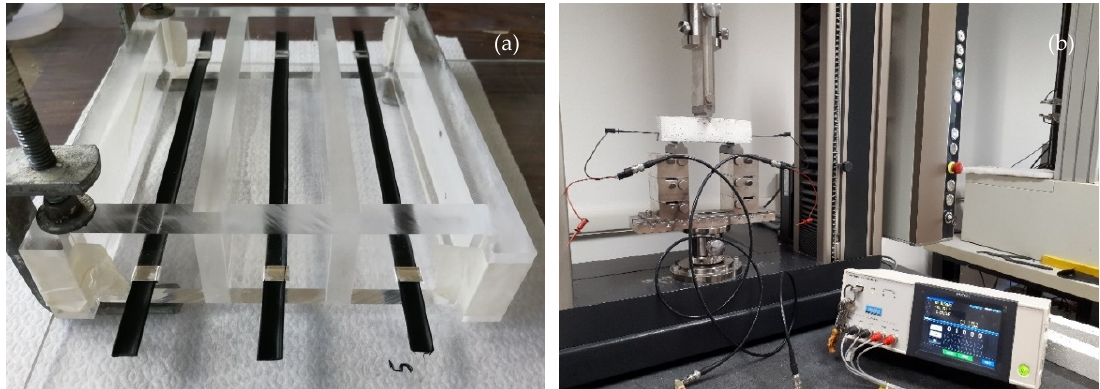
Figure 1. ( a ) Polypropylene / carbon nanotubes (PP / CNT) strips in the PMMA mold and ( b ) impedance measurement